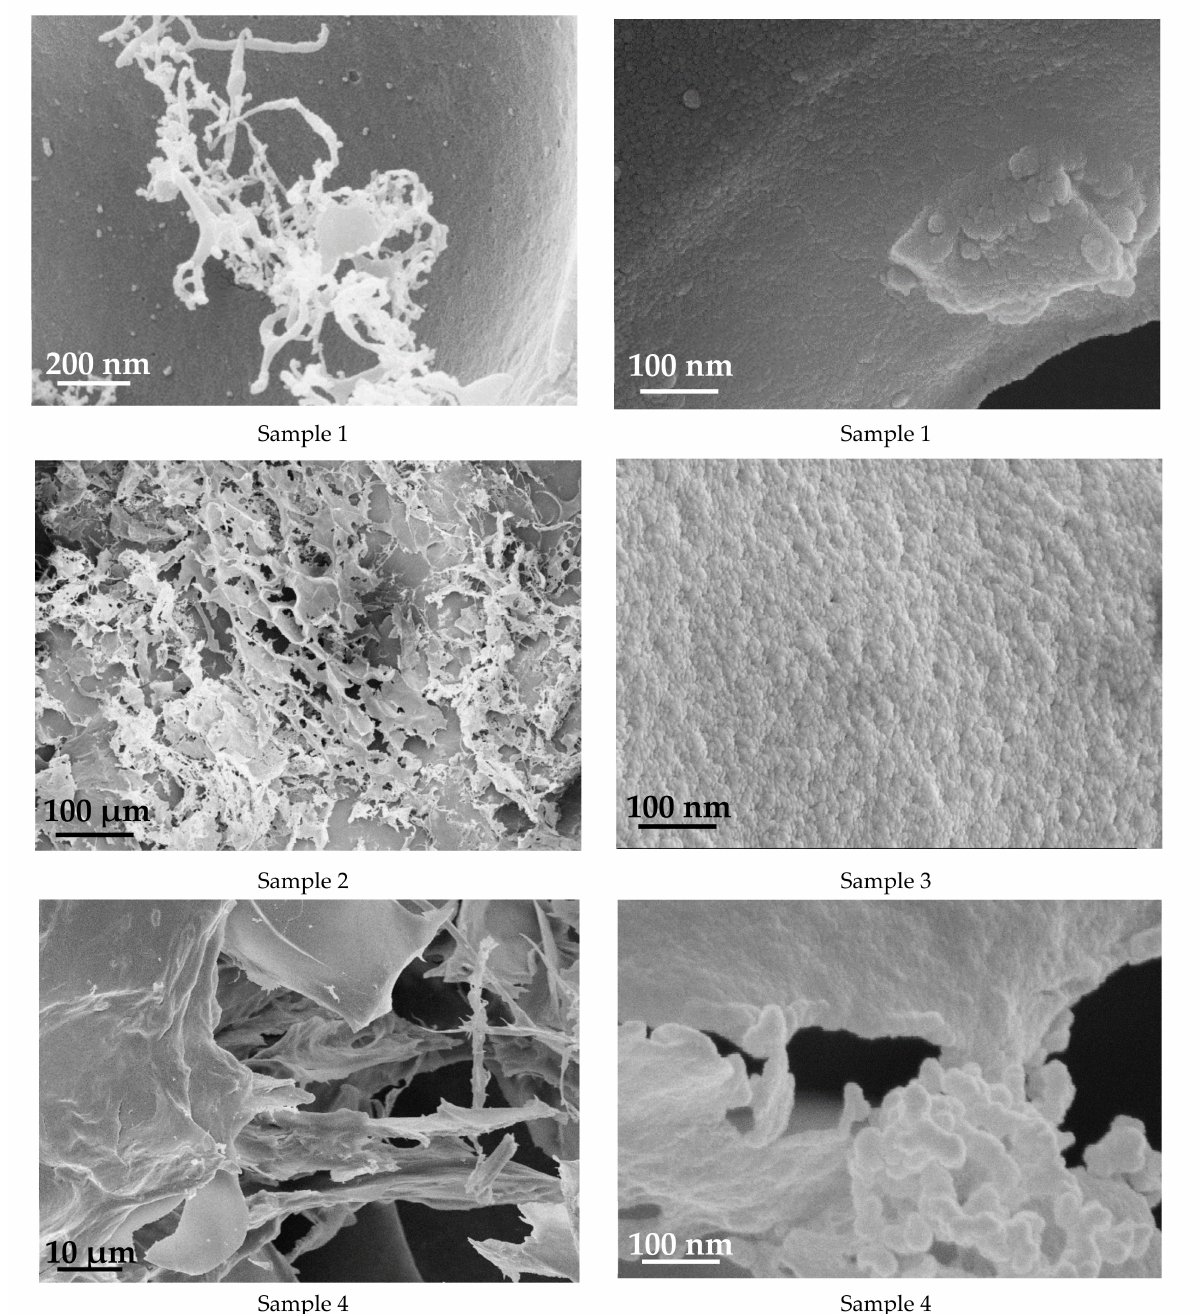
Figure 5. SEM images of chitin cryogels (Samples